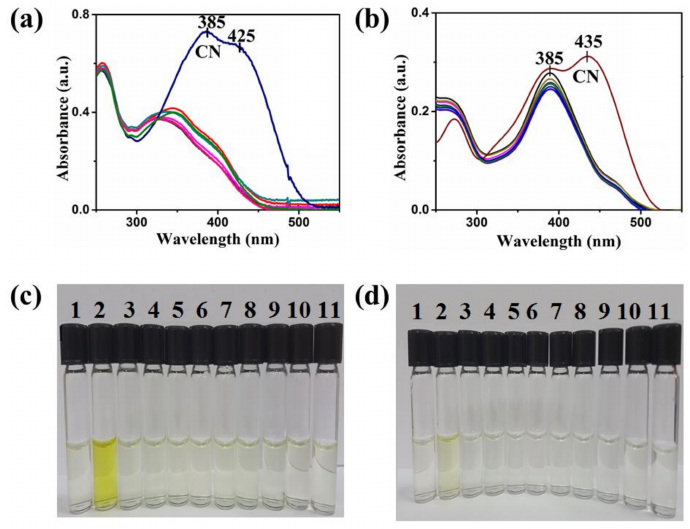
Figure 2. ( a ) UV-vis Spectra of 1 in the presence of different anions n water: acetonitrile 90:10: ( –1 ; – SCN − , – N 3 − , – I − , – H 2 PO 4 − , – H 2 AsO 4 − , – F − , – CN − , – Cl − , – +Br − , – AcO − ); ( b ) UV-vis